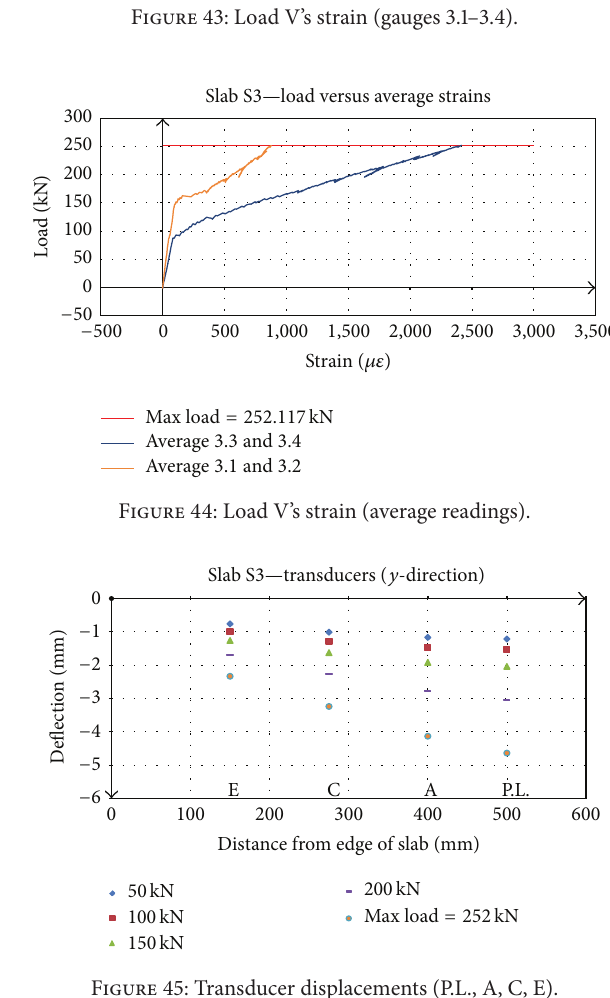
Figure 45: Transducer displacements (P.L., A, C,